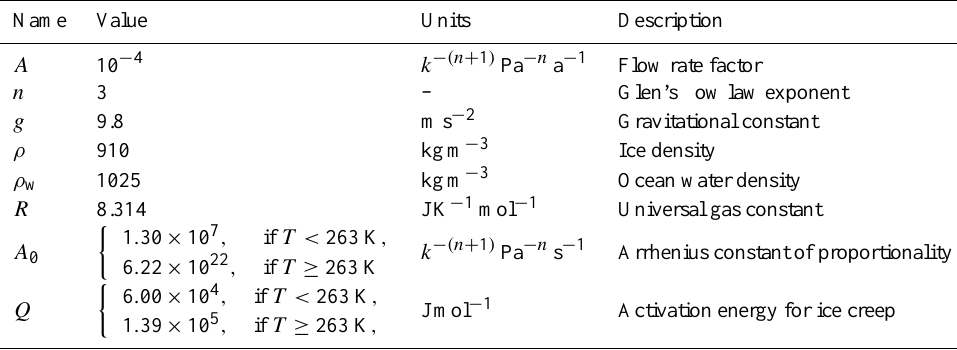
Table 1. Physical parameter values for first-order Stokes equations and boundary conditions ∗ .